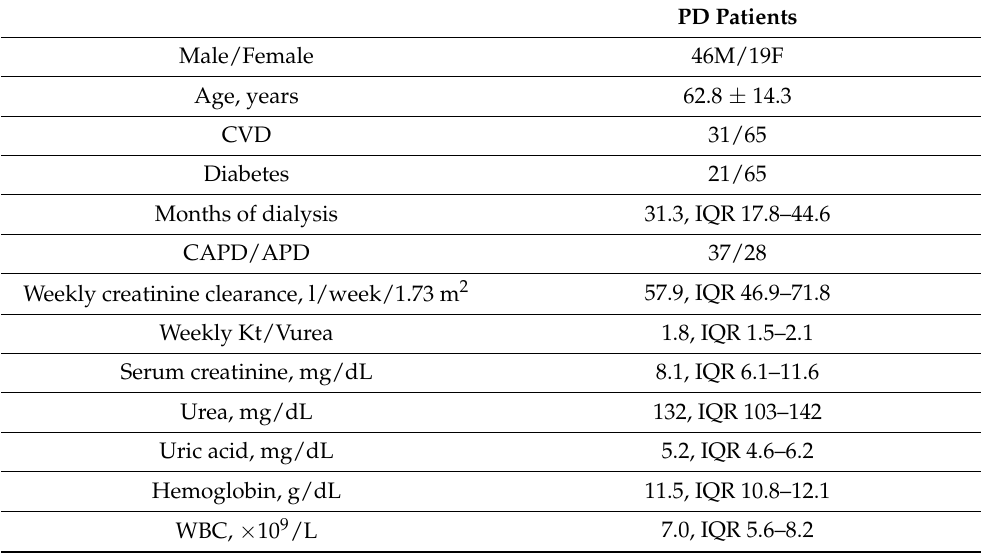
Table 1. Clinical, laboratory, and PD-related parameters of all 65 patients included in the study.